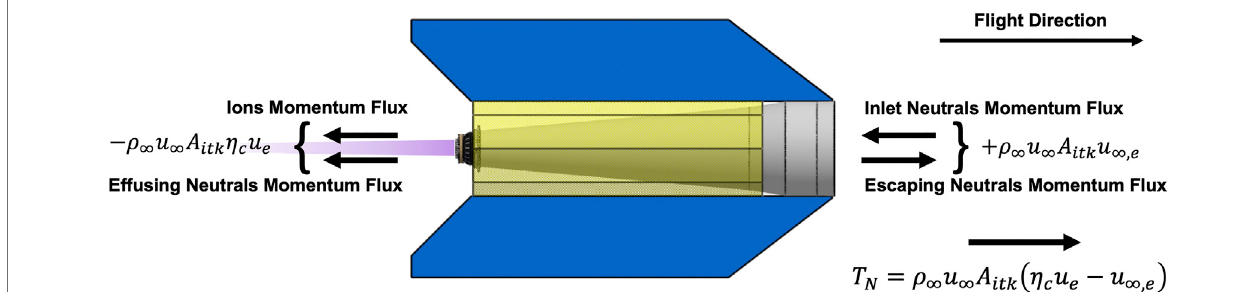
FIGURE 5 | Momentum conservation in propulsion system control volume.